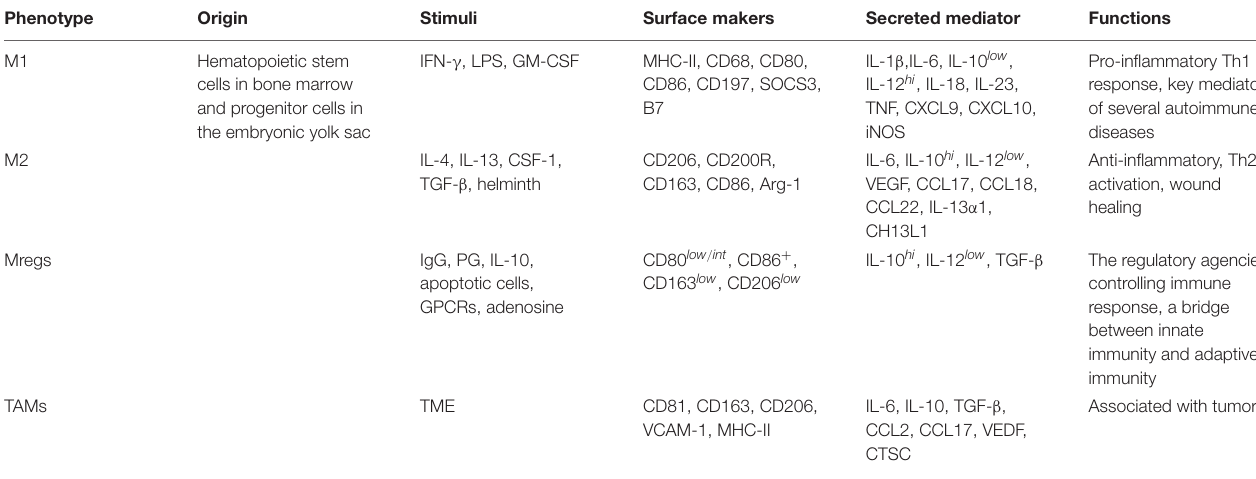
TABLE 1 | Phenotype of macrophages and its correlation with stimulating factors, surface markers, cytokines, and functions.